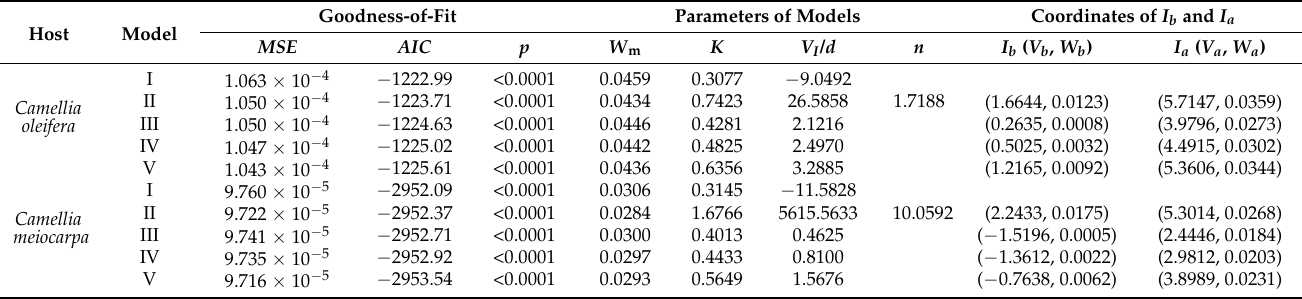
Table 1. Fitting effect between larval dry mass (g) and fruit size (cm 3 ), model parameters and